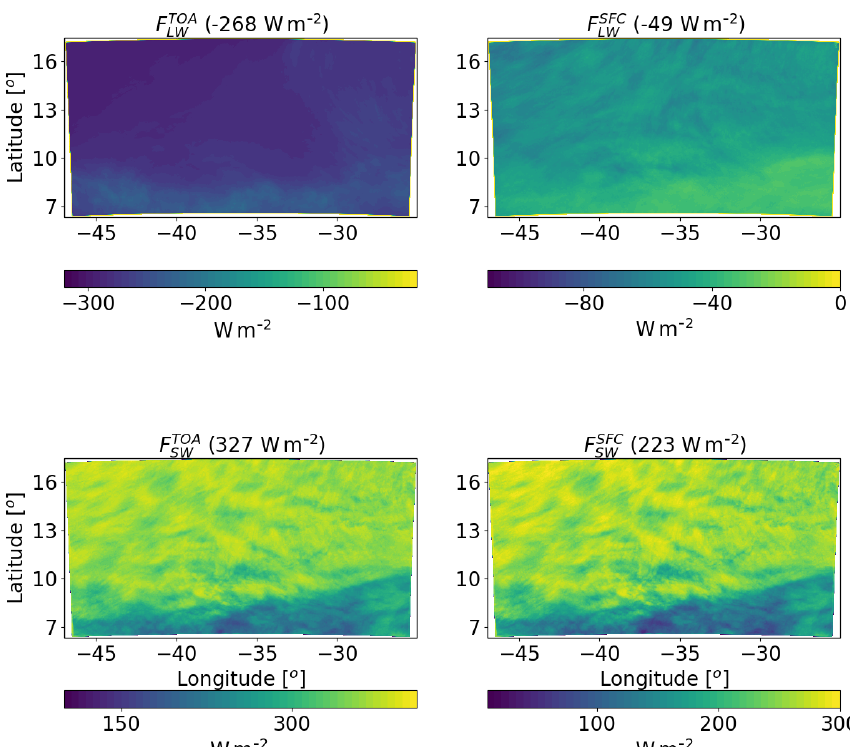
Figure 5. Spatial distribution of ICON-simulated time-mean longwave (LW) and shortwave (SW) radiation fluxes at the top of atmosphere (TOA) and surface (SFC) for a simulation of the shallow-cloud-dominated case (10–12 August 2016) with CDNC = 20cm − 3 . The domain- and time-mean value of each term appear in